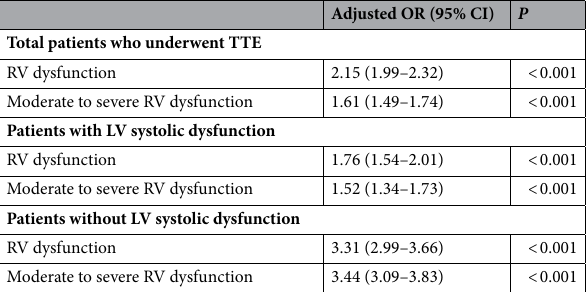
Table 2. Propensity score weighting analyses for predicting in-hospital mortality. CI confidence interval, LV left ventricular, OR odds ratio, RV right ventricular, TTE transthoracic echocardiography.